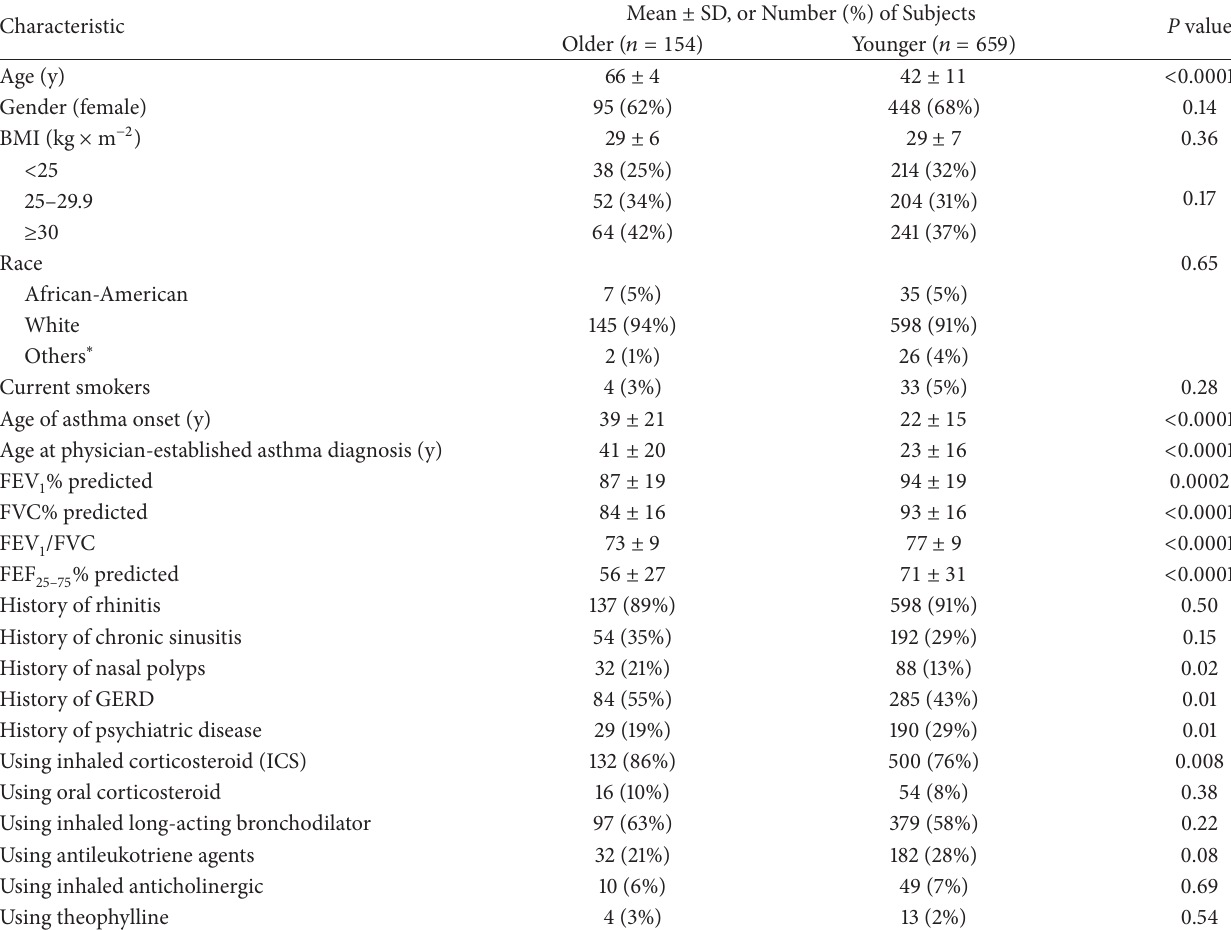
Table 1: Demographic and physiologic characteristics, medical history, and medication use for older and younger asthma subjects. Characteristic